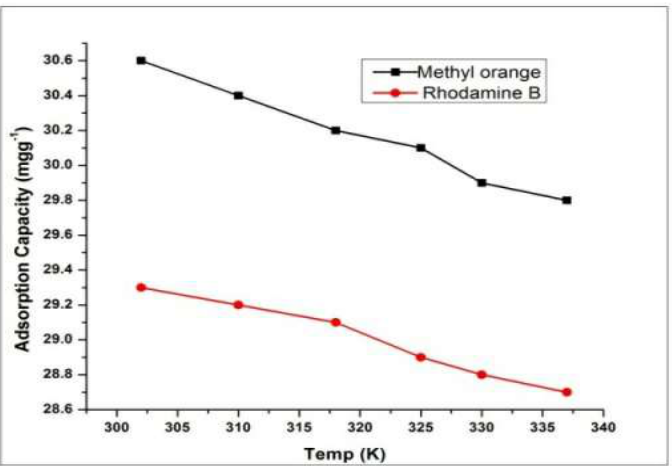
Figure 13. Effect of temperature on dyes adsorption.